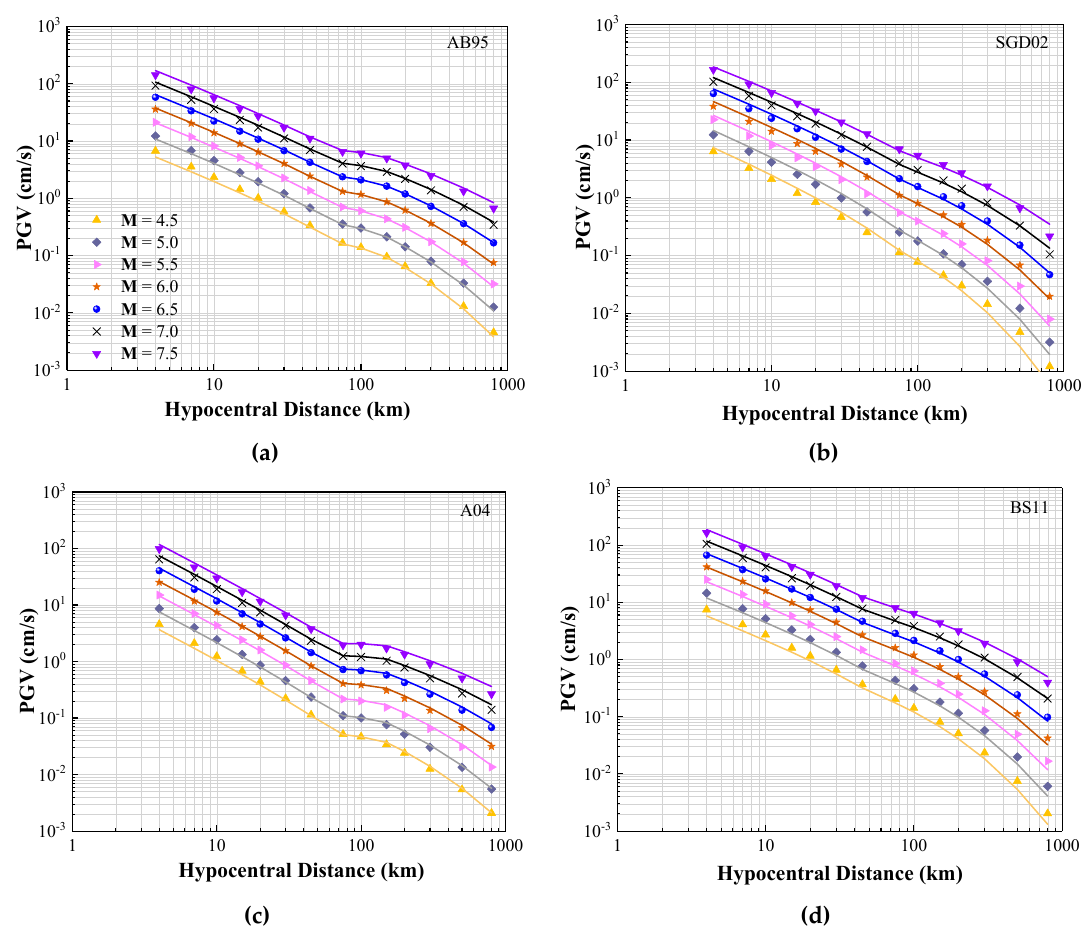
Figure 9. Comparison between predictions by CAM (lines) and simulations of seismological models (symbols). ( a ) AB95 model, with trilinear geometric spreading and Q 0 = 680; ( b ) SGD02 model, with magnitude-dependent geometric spreading and Q 0 = 351; ( c ) A04 model, with trilinear geometric spreading and Q 0 = 893; ( d ) BS11 model, with bilinear geometric spreading and Q 0 =